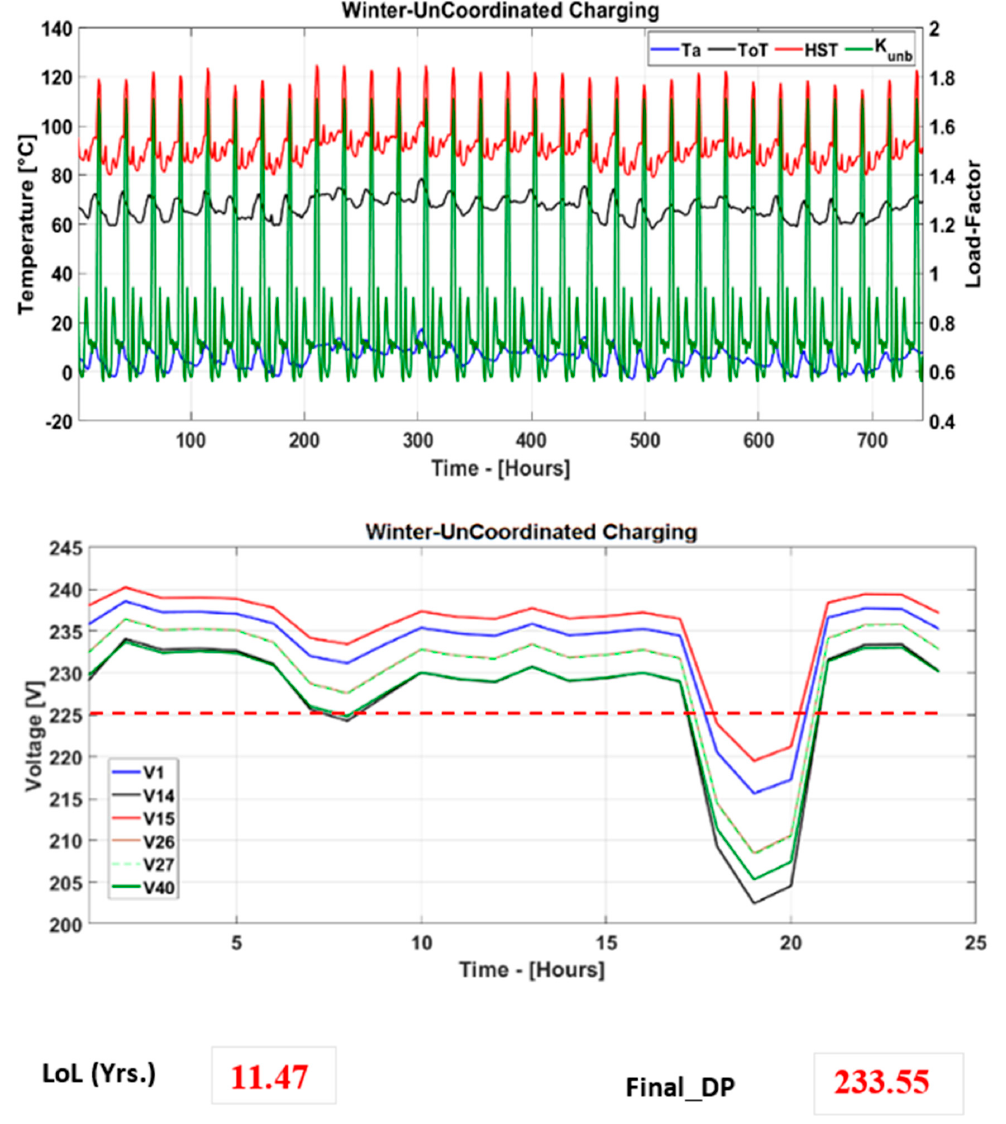
Figure 3. Output under uncoordinated charging across selected households, during winter, without BESS.